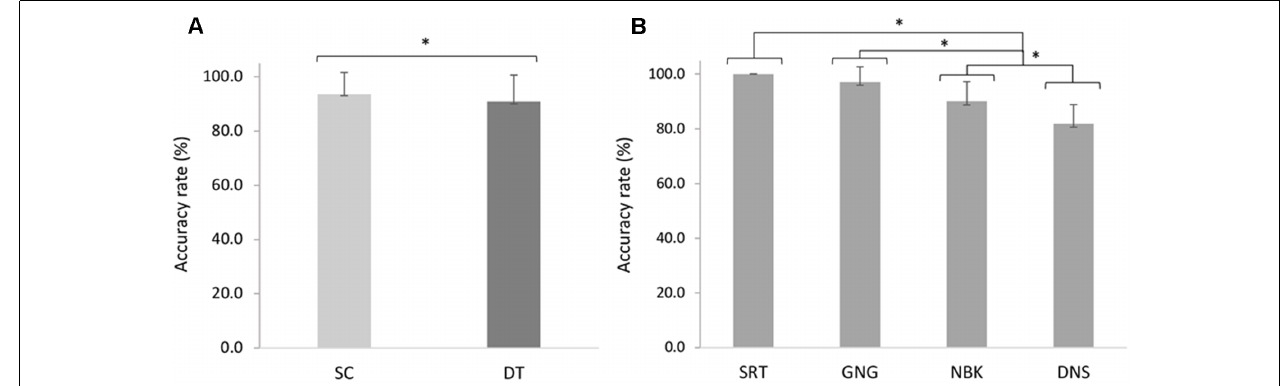
FIGURE 4 | Mean changes in accuracy rates (%) across (A) single (SC) and dual (DT) tasks ( F (1,18) = 15.42, p = 0.001, η 2 p = 0.46). (B) Simple reaction time (SRT), go/no-go (GNG), n-back (NBK) and double number sequence (DNS) accuracy rates across cognitive demands ( F (3,54) = 63.82, p < 0.001, η 2 p = 0.78). Error bars represent standard deviation and ( ∗ ) denotes a significant difference ( p < 0.05).